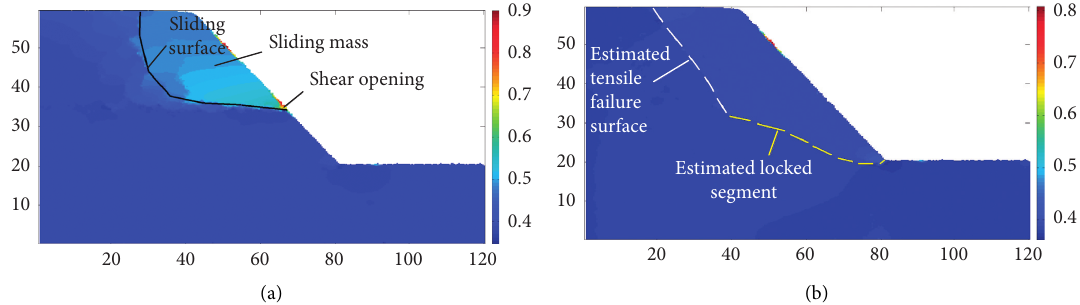
Figure 23: Contour of displacement. (a) Slope with a weak interlayer under fling step. (b) Homogeneous slope under fling